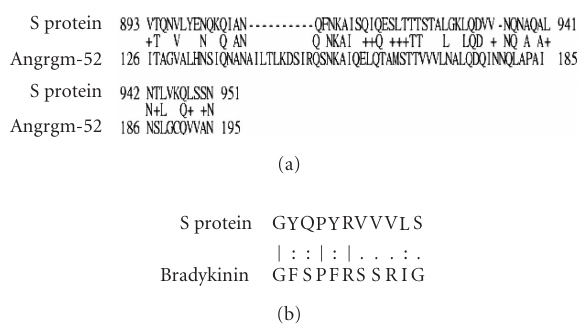
Figure 2: Sequence homology between S protein, (a) human Angrgm-52, and (b) bradykinin. Spike protein sequence (pro- tein databank NP 828851) was compared with sequences from all nonredundant GenBank CDS translations, PDB, SwissProt, PIR, and PRF of human, by using blastp (NCBI, NIH, USA). For Panel (a), BLASTP was used to calculate the similarity between S protein and human Angrgm-52, with matrix set at default. For an identical residue, one letter symbol of amino is shown between the two se- quences, and for a conservative substation, “+” is shown. For Panel (b), pairwise alignment was calculated based on Smith-Water lo- cal alignment with matrix set at BLOSUM 45. “ | ” is annotated for identical residues; “:” and “.” are for similar